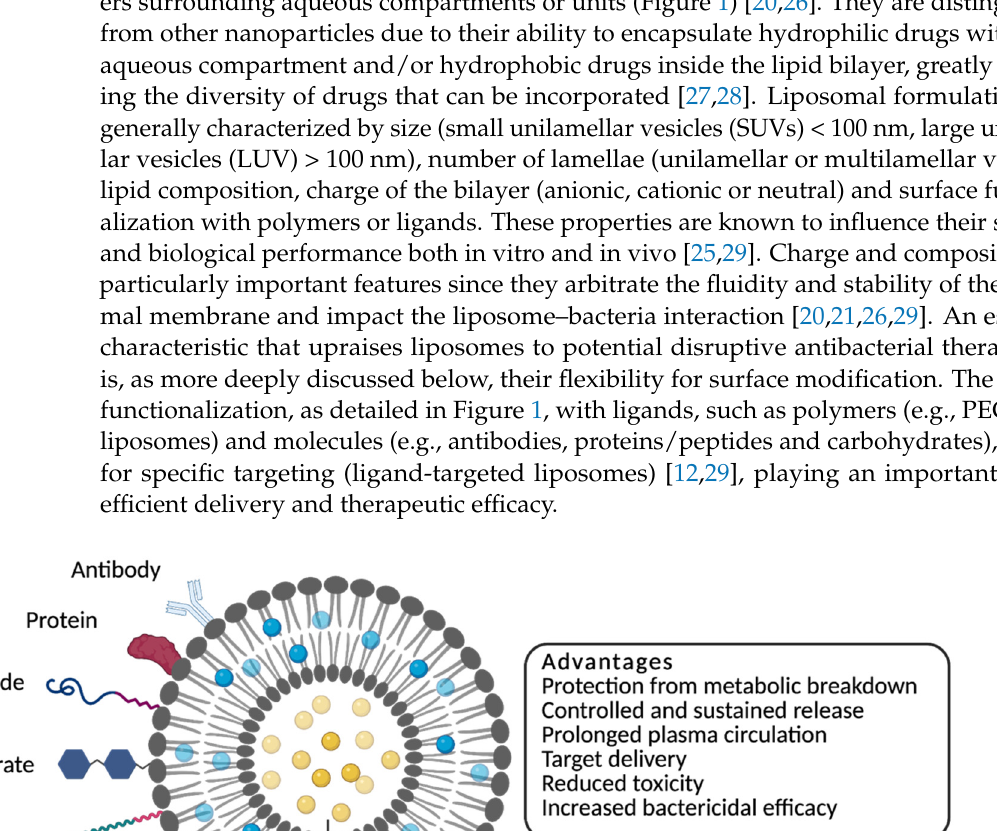
Figure 2. Schematic representation of the main advantages of liposomes as antibiotic carriers.